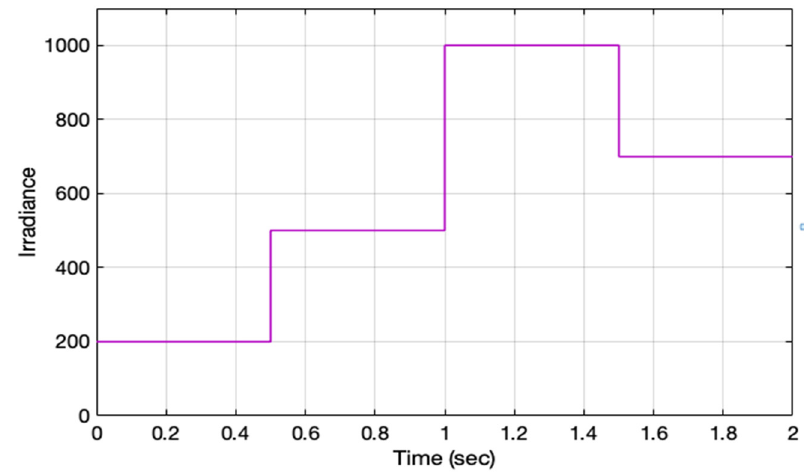
Figure 9. Variable input irradiance.